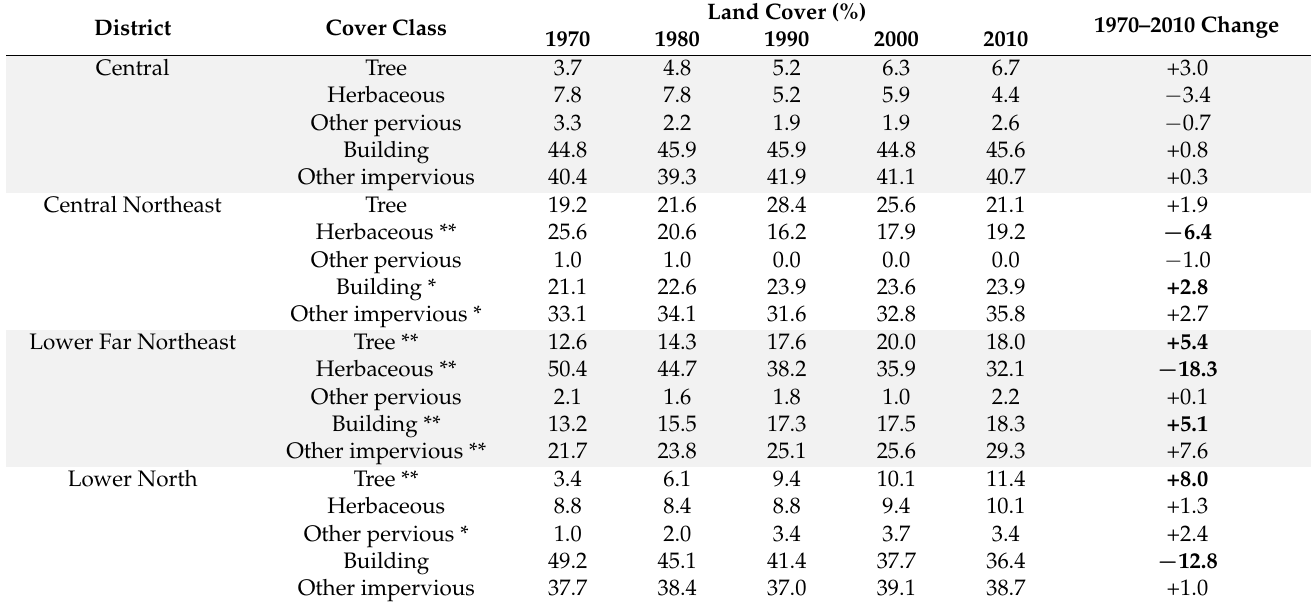
Table 4. Land cover change for planning districts in Philadelphia. Statistically significant changes from 1970–2010 are noted with * ( p < 0.05) and ** ( p < 0.01). Detectable change over 40 years is noted in bold ( ± 3.2 for tree cover, 4.7 herbaceous, 7.4 other pervious, 1.2 building, and 9.1 other impervious). Some land cover values in a given year do not sum to 100 due to rounding. Grey shading serves only to enhance